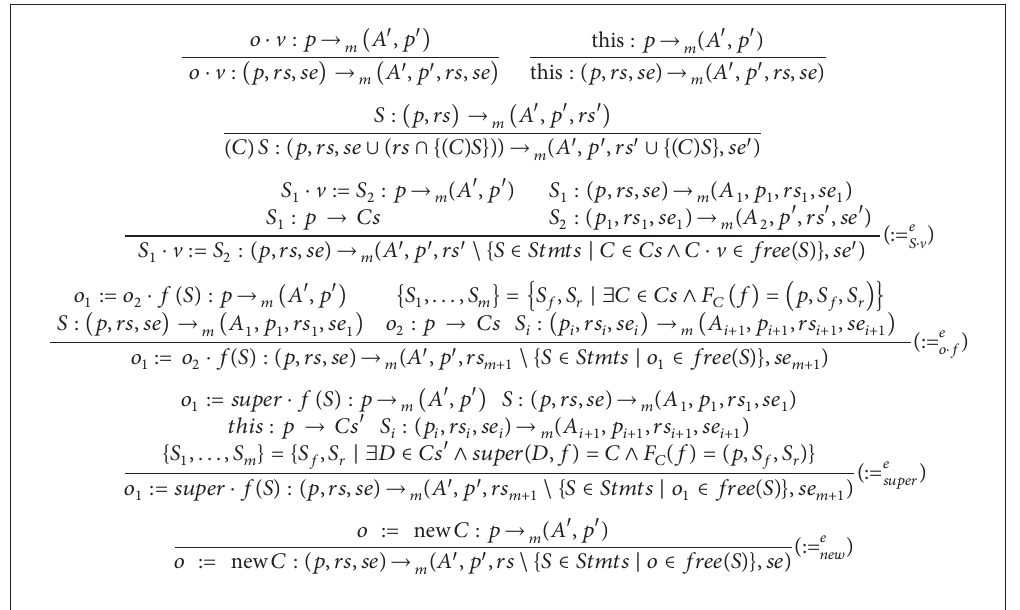
Algorithm 6: An extension for the semi-expectation type